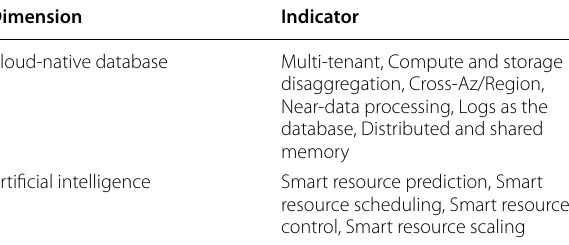
Table 6 The description of the indicators of cloud-native dimension